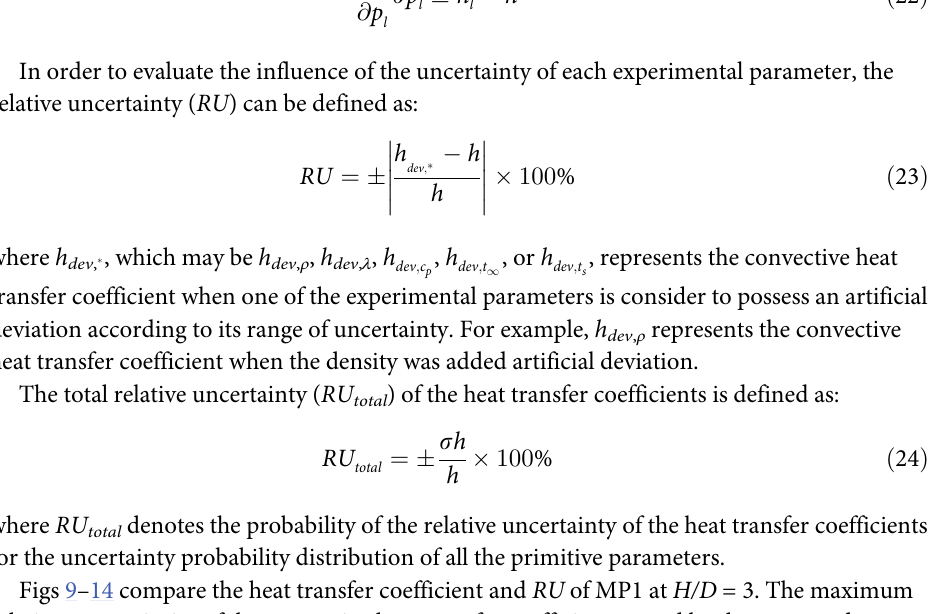
Fig 9. Comparison of h